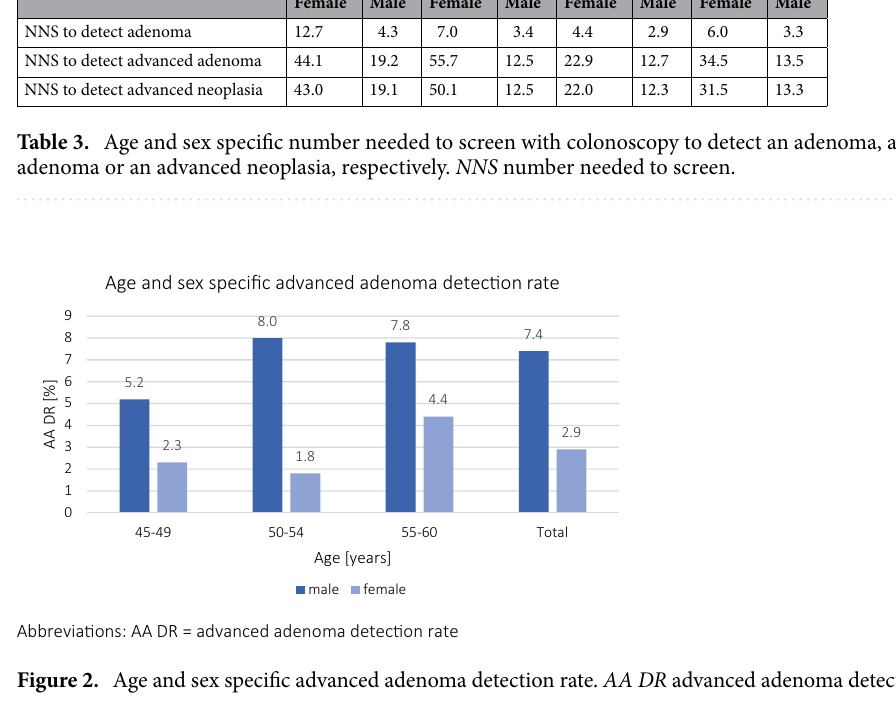
Figure 2. Age and sex specific advanced adenoma detection rate. AA DR advanced adenoma detection